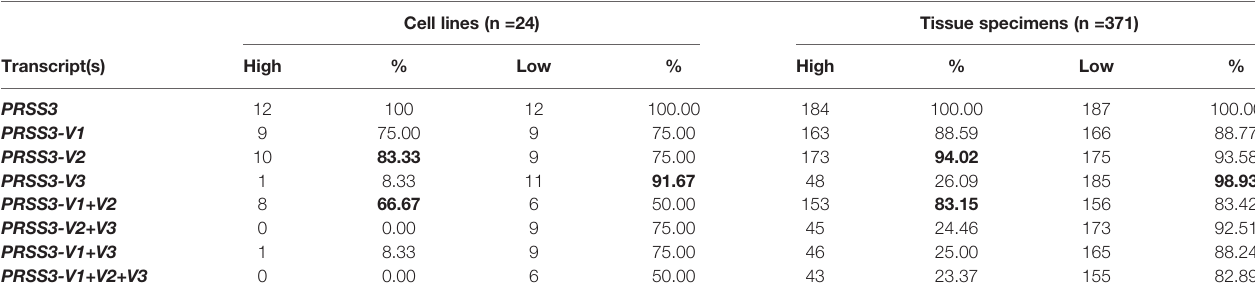
TABLE 2 | Predominance and coexpression of PRSS3 transcripts in HCC cell lines and tissues. Cell lines (n =24) Tissue specimens (n